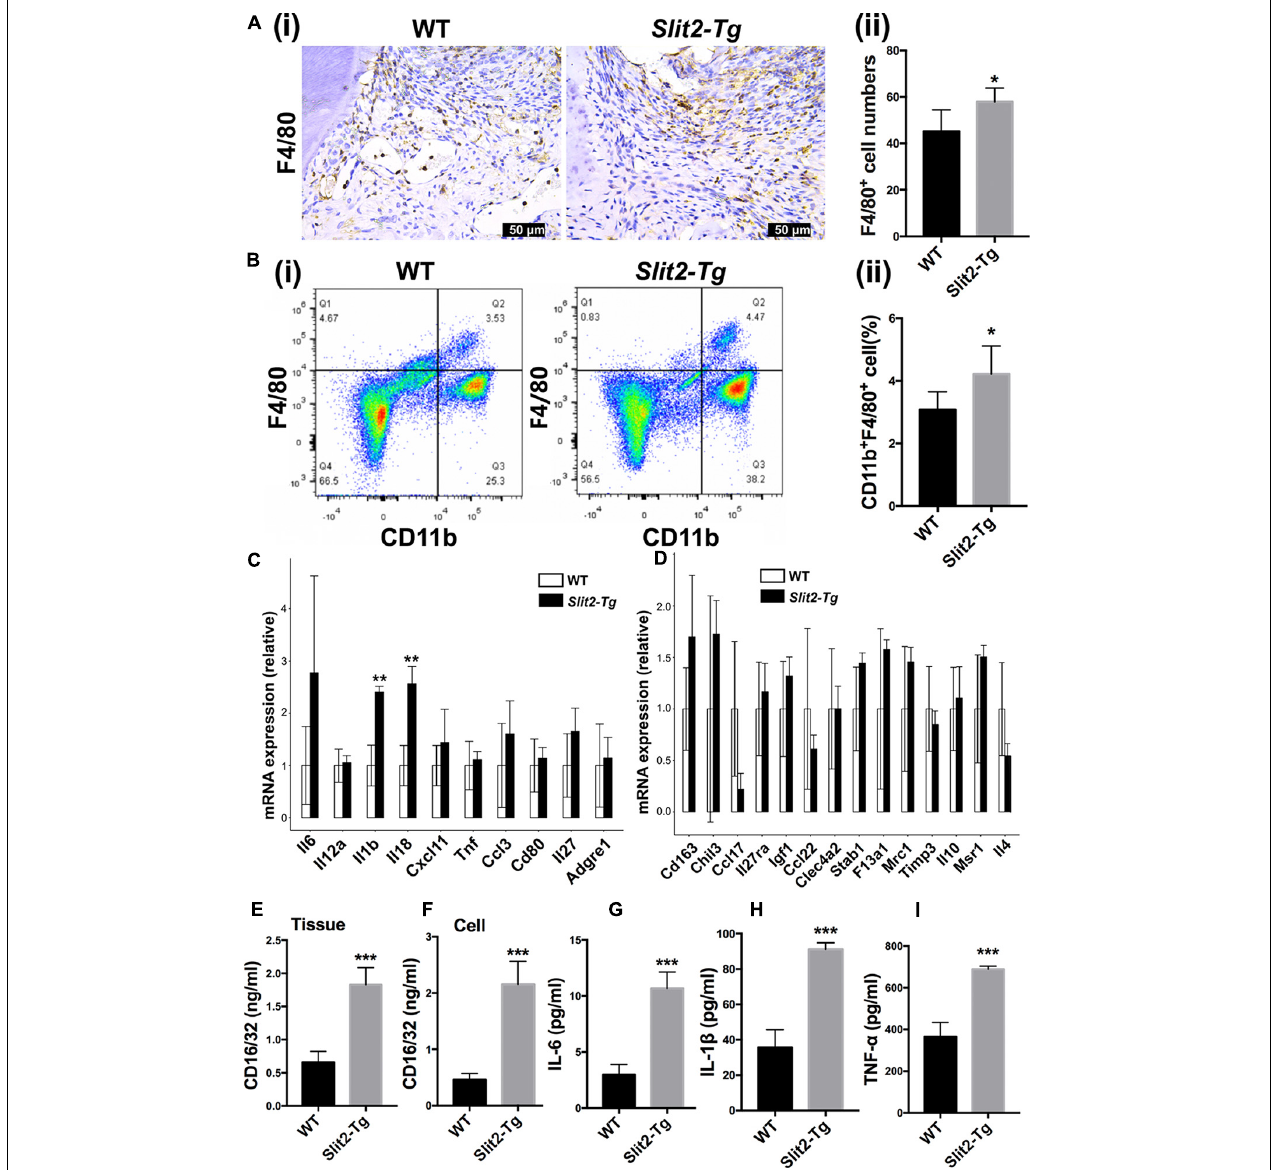
FIGURE 5 | SLIT2 overexpression induces M1 macrophage polarization in PAPT. (A (i)) Representative F4/80 immunohistochemistry images of the PAPT section. (A (ii)) Quantification of F4/80 expressing cells in a PAPT section from immunohistochemistry images ( n = 6). (B (i)) Flow cytometry analysis of F4/80 positive relative frequency of gated populations from PAPT. (B (ii)) Quantitative analysis of F4/80+ flow cytometry data ( n = 5). Relative mRNA expression of (C) M1, and (D) M2 macrophage polarization related genes analyzed by RNA sequencing ( n = 3). (E) Protein level expression of CD16/32 in PAPT ( n = 6). Protein level expression of, (F) CD16/32 in cell lysates of LPS-treated BMMs. Protein expression of (G) IL-6, (H) IL-1 β , and (I) TNF- α in conditioned medium of LPS-treated BMMs ( n = 4). Data are presented as mean ± SD. The significant difference among the groups, * P < 0.05, ** P < 0.01, *** P < 0.001.